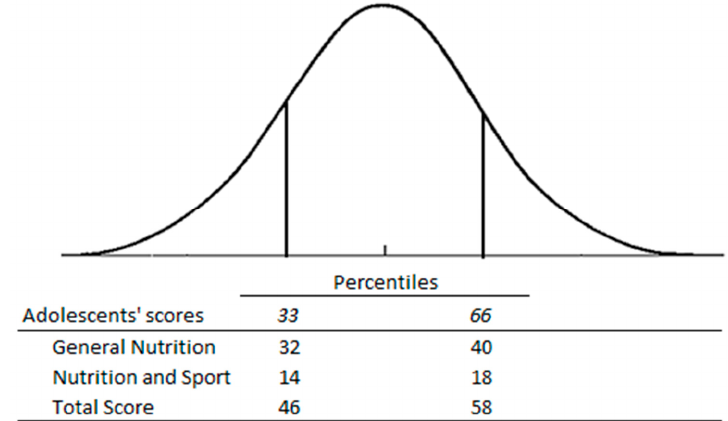
Figure 3. Scores that define three scores categories: low, medium, and high knowledge level in adolescents.